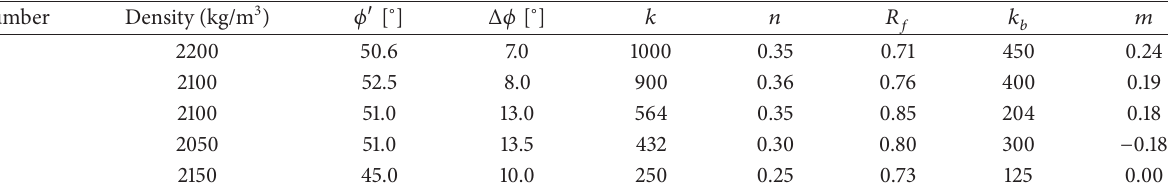
Table 3: Computational parameters for the rockfill materials.